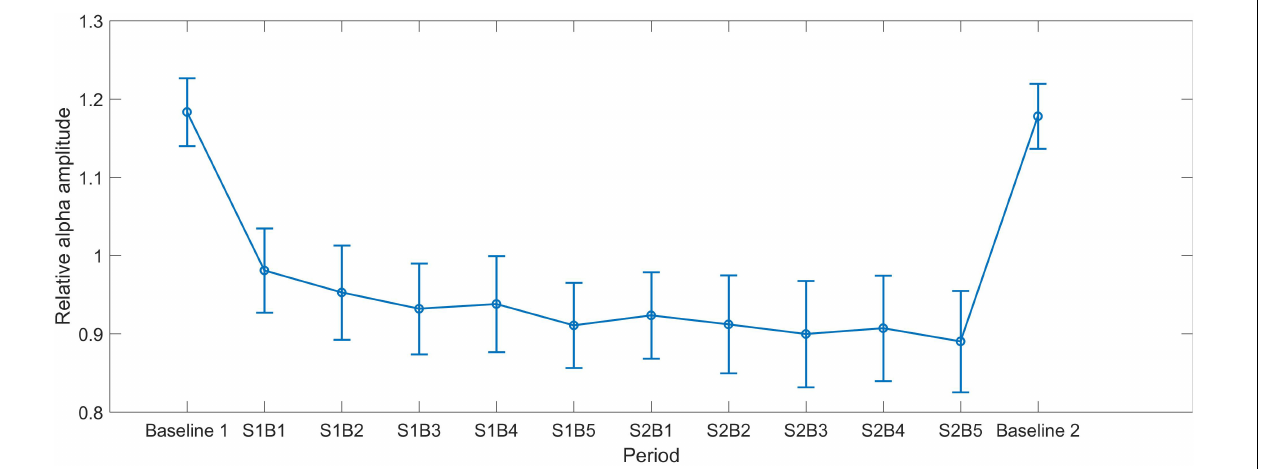
FIGURE 1 | The mean alpha curves across all periods. S indicates session and B indicates block, e.g., S1B1 indicates the first block in Session 1. Baseline 1 and Baseline 2 represent the eyes-open baseline before and after NF, respectively. The error bars represent the standard error of the mean (SEM).